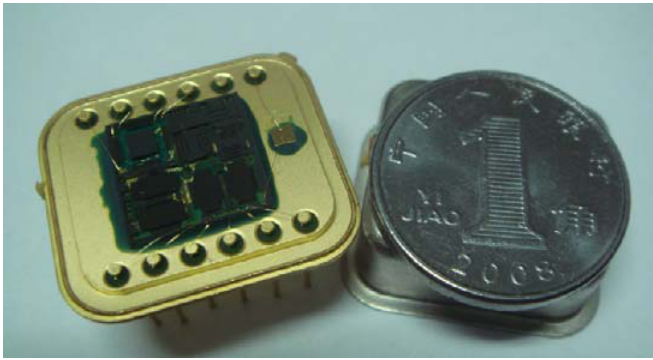
Figure 13. Photo of the final MIMU.